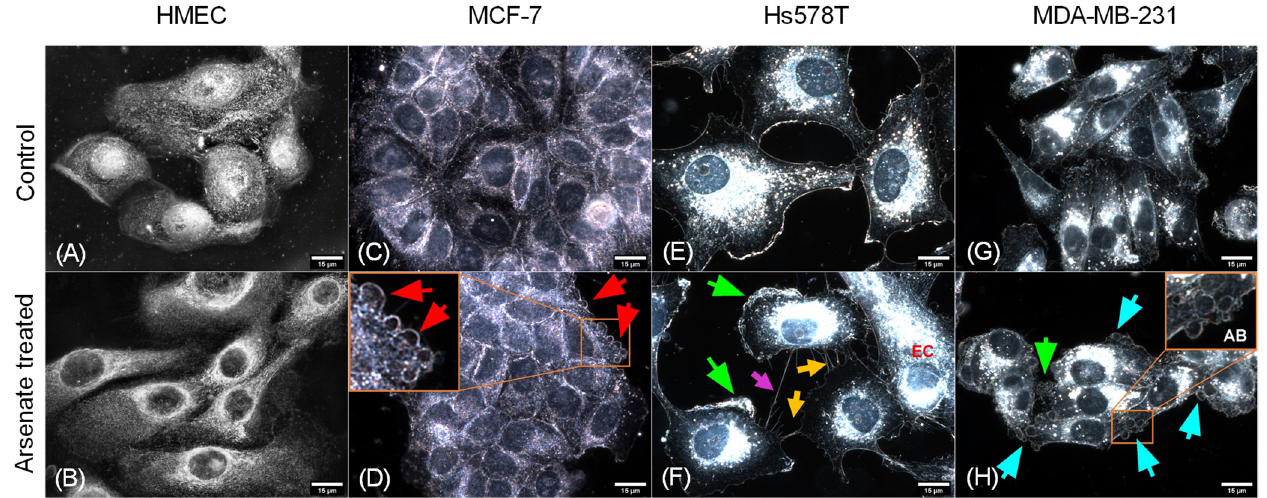
Figure 2. Effect of arsenate treatment on four different cell lines visualized using dark field microscopy. Magnification of 15 μ m. ( A ) HMEC untreated cells, ( B ) HMEC arsenate treated cells, ( C ) MCF-7 untreated cells, ( D ) MCF-7 arsenate treated cells, ( E ) Hs578T untreated cells, ( F ) Hs578T arsenate treated cells, ( G ) MDA-MD-231 untreated cells, ( H ) MDA-MD-231 arsenate treated cells. Red arrows ( D ) indicate apoptotic bodies; green arrows ( F , H ) indicate thickened and fragmented cell membranes. EC (orange—( F )) elongated cell, orange arrows ( F ) indicate apoptopodia-like projections, magenta arrows ( F ) indicate tunneling nanotubes, cyan arrows ( H ) show apoptotic bodies labeled AB. No important alterations can be seen for normal cell lines; meanwhile, in the case of tumor cells, the activation of apoptotic mechanisms can be observed (indicated by red arrows), which is more pronounced for TNBC cells.